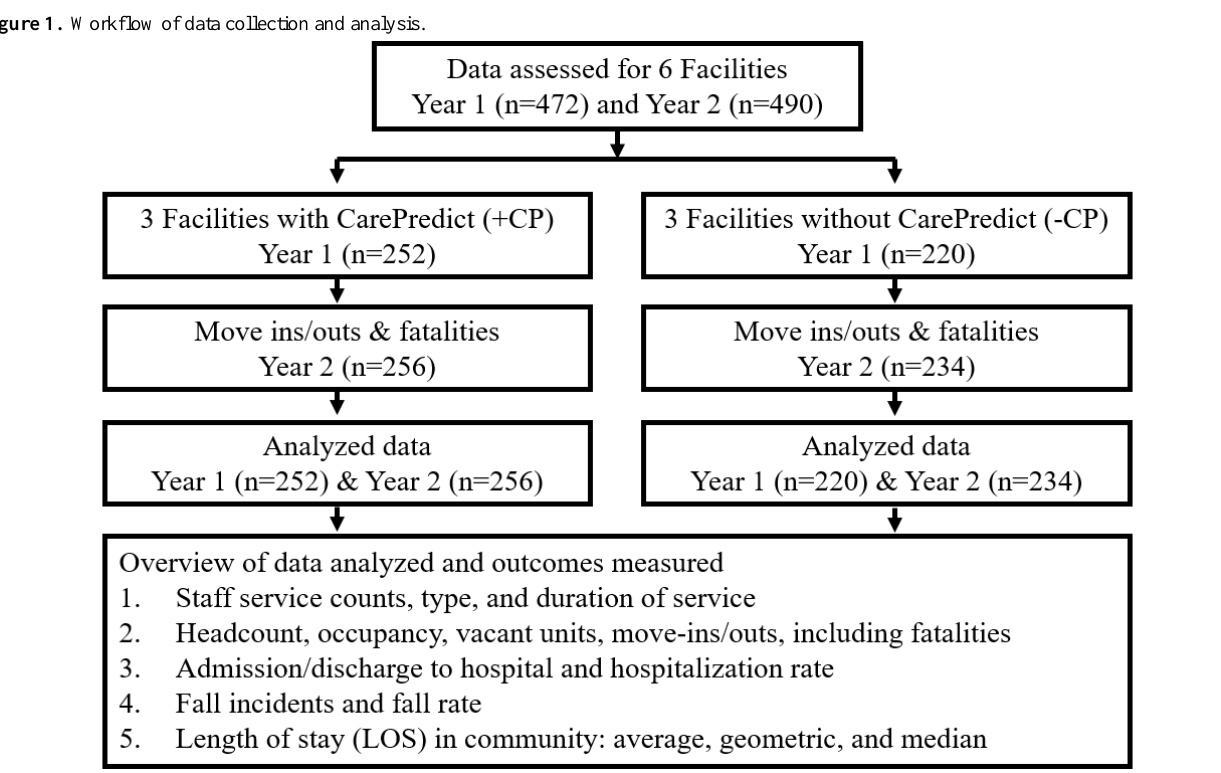
Figure 1. Workflow of data collection and